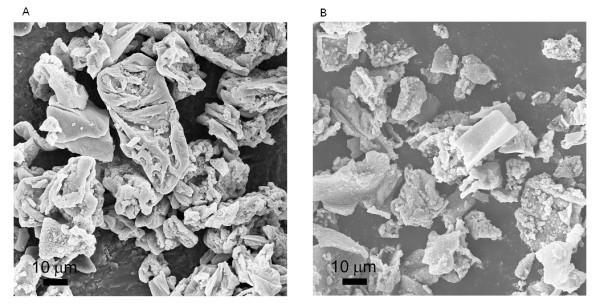
FESEM images of ZnO nanostructures obtained with the  ratio of 3.2:1.0. From the precipitation reaction between (A) Zn(CH3COO)2·2H2O and Na2CO3, and (B) ZnSO4·7H2O and Na2CO3.